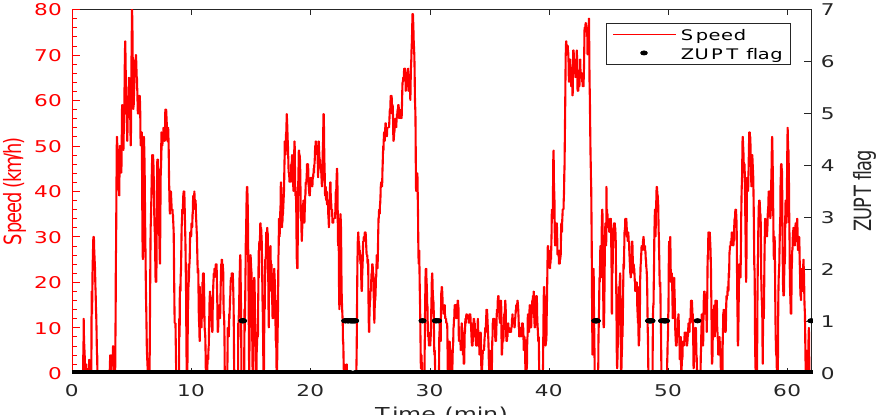
Figure 9. Vehicle speed profile and Zero-Velocity Update (ZUPT) flag of the second